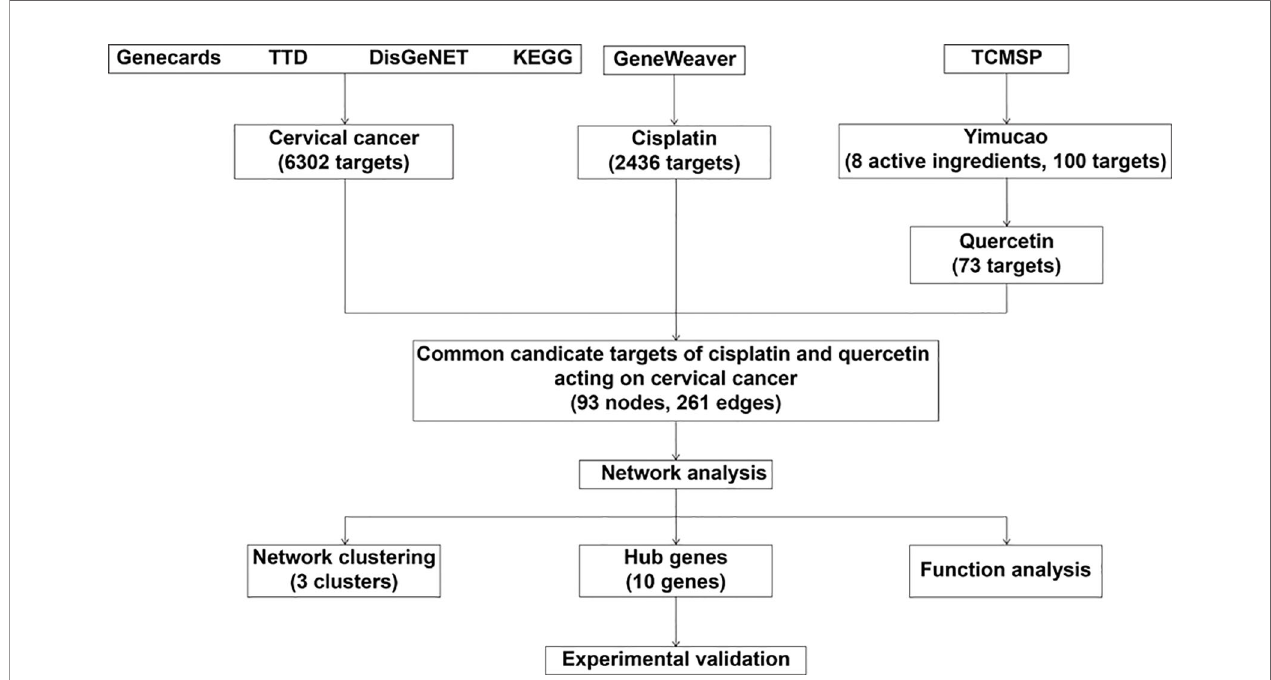
FIGURE 1 | Schematic of the network pharmacological analysis used to identify the potential mechanism by which quercetin enhances cisplatin action in cervical cancer. TTD, Therapeutic Target Database; KEGG, Kyoto Encyclopedia of Genes and Genomes; TCMSP, Traditional Chinese Medicine Systems Pharmacology Database (TCMSP)